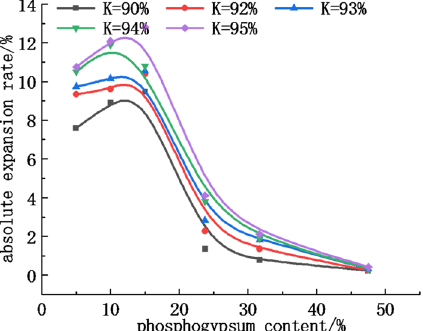
Fig. 8 relationship between linear shrinkage of mixture and phos- phogypsum content (3%